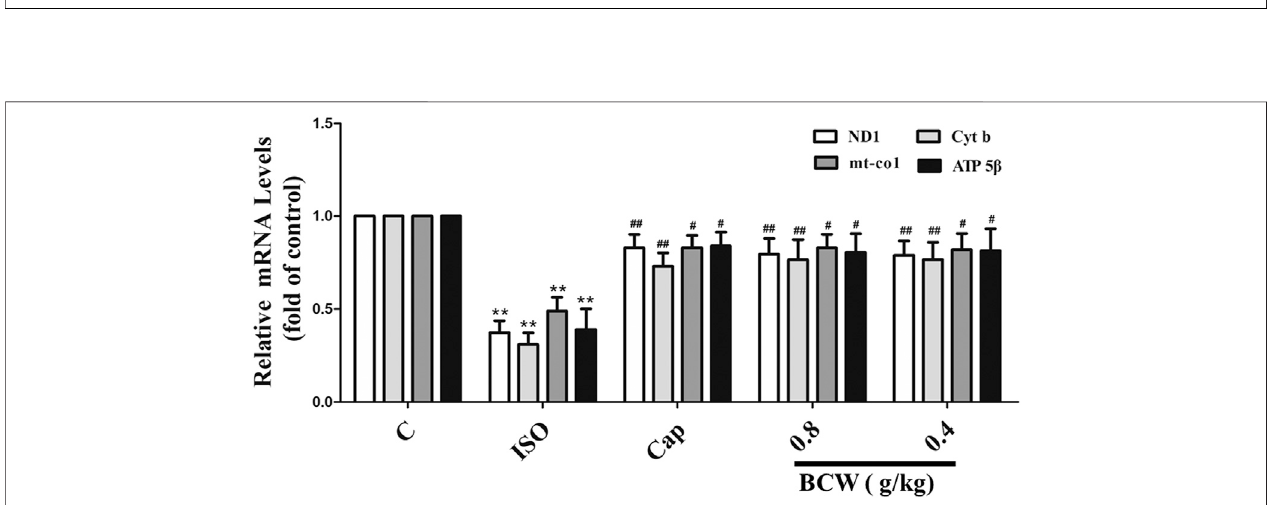
FIGURE 5 | BCW alleviated ISO-induced myocardial hypertrophy by modulating glucolipid metabolism and improving oxidative phosphorylation. (A and B) The levels of LD and FFA were measured by LD and FFA detection kit, respectively. (C and D) The protein expression of CPT-1 β and GLUT-4 were determined by Western blotting. (E and F) Densitometric analysis of the immunoblotting was expressed as a percentage of control. Results are shown as the mean ± SE. * p < 0.05 vs. control, ** p < 0.01 vs. control; # p < 0.05 vs. ISO, ## p < 0.01 vs. ISO, n (cid:2) 10 in each group.